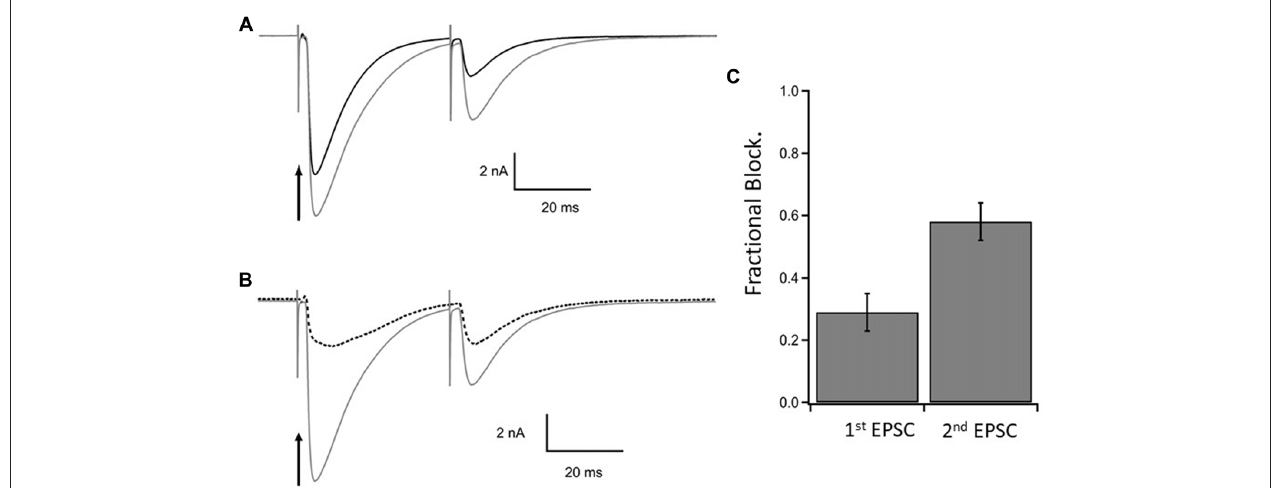
FIGURE 4 | Steady state inhibition of climbing fiber paired pulse EPSCs. (A) Control paired EPSCs in gray and test EPSCs in black following photorelease of 1.1 mM γ - D GG at the time of stimulation of the first EPSC. Paired stimulations 40 ms interval. γ - D GG inhibits the second EPSC more than the first. (B) The current blocked by γ - D GG (dashed line) was obtained by subtracting test (black trace) from control (gray trace) and is compared to control. (C) Fractional block of the peak current of 1st and 2nd EPSC following a flash to release γ - D GG at the first stimulus; data from 10 cells, Mean ± SEM. Range of γ - D GG concentrations released 0.55–1.7 mM. Note that diffusional loss of photoreleased γ - D GG is negligible on this time scale (see Figure 1C ). Panels (B,C) show that the γ - D GG blocked component is a greater fraction of the control in the second EPSC than the first, indicating a lower competing transmitter concentration in the second